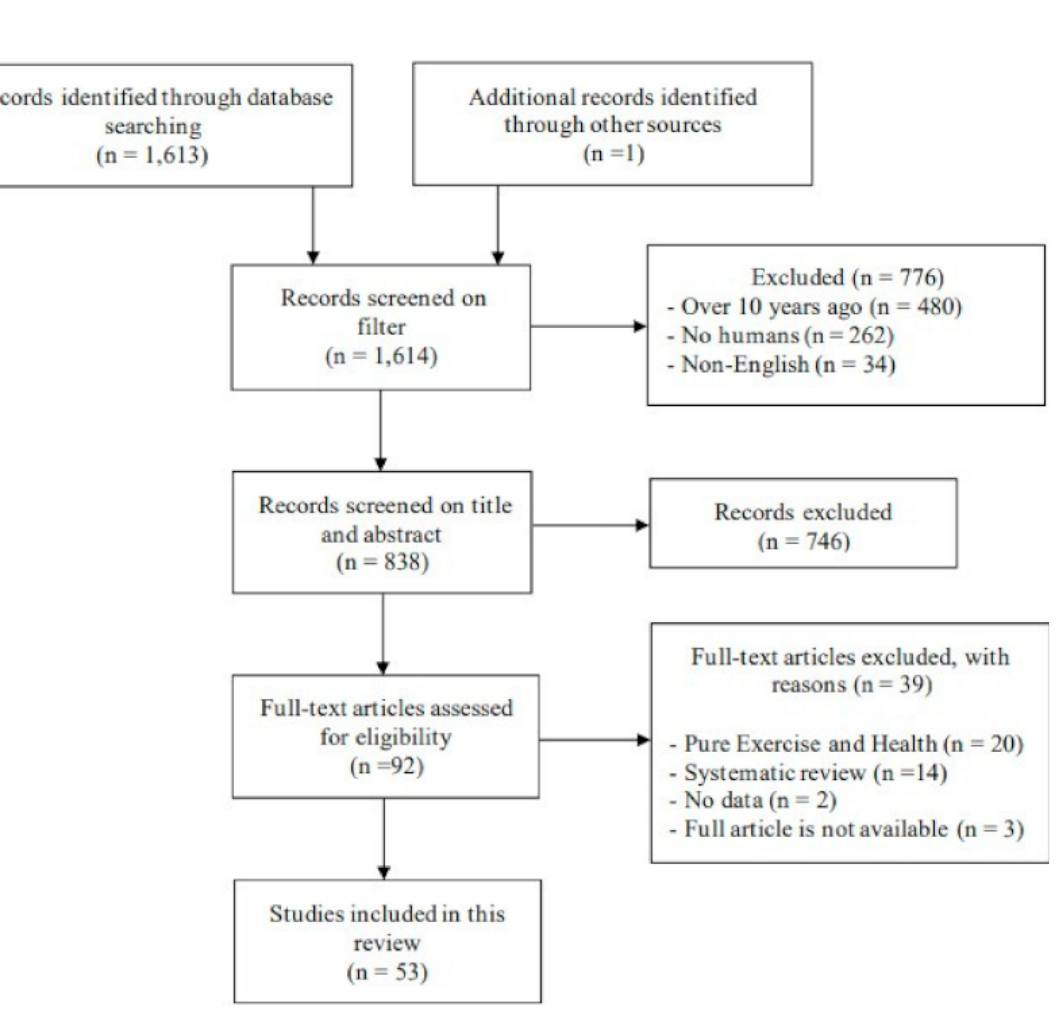
Figure 1. PRISMA diagram for scoping